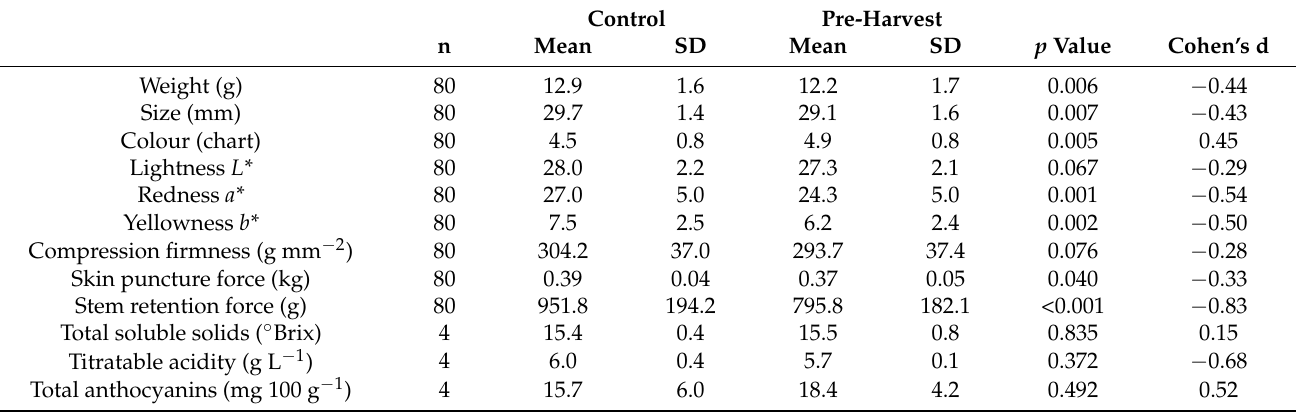
Table 3. Selected fruit quality parameters at commercial harvest arising from trees from control and pre-harvest L-proline application. Control